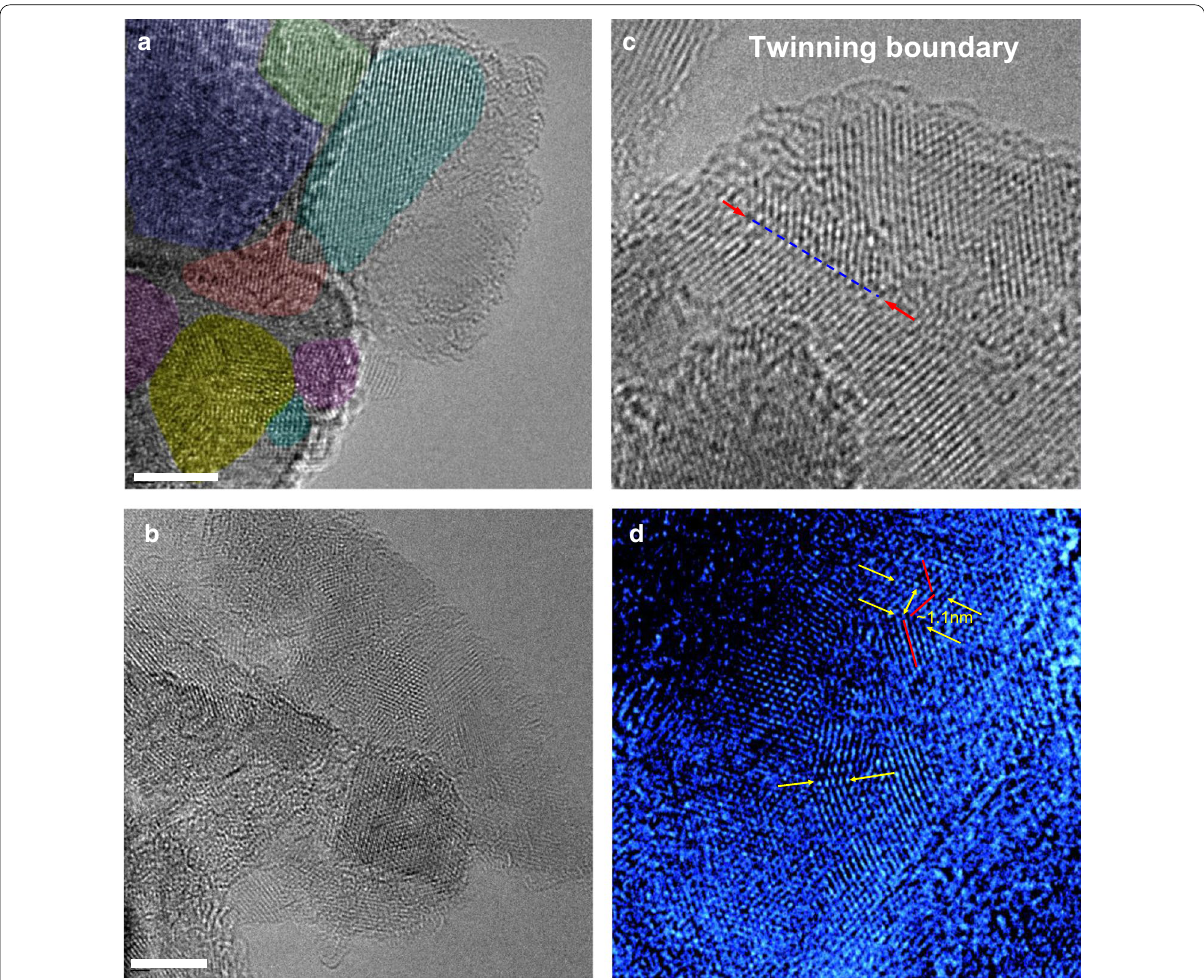
Fig. 4 High-resolution TEM images of selected cubic diamond polycrystals extracted from the DP 0–0.05 powder ( a , b ) and typical images of the simple twinning boundaries, of several nanometres in length, found occasionally in the sample ( c , d ). Panels ( a , b ): scale bar—4 nm. Different crystallites are highlighted in different colours in ( a ). Arrows in panels ( c ) and ( d ) mark the selected clearly distinguishable twinning